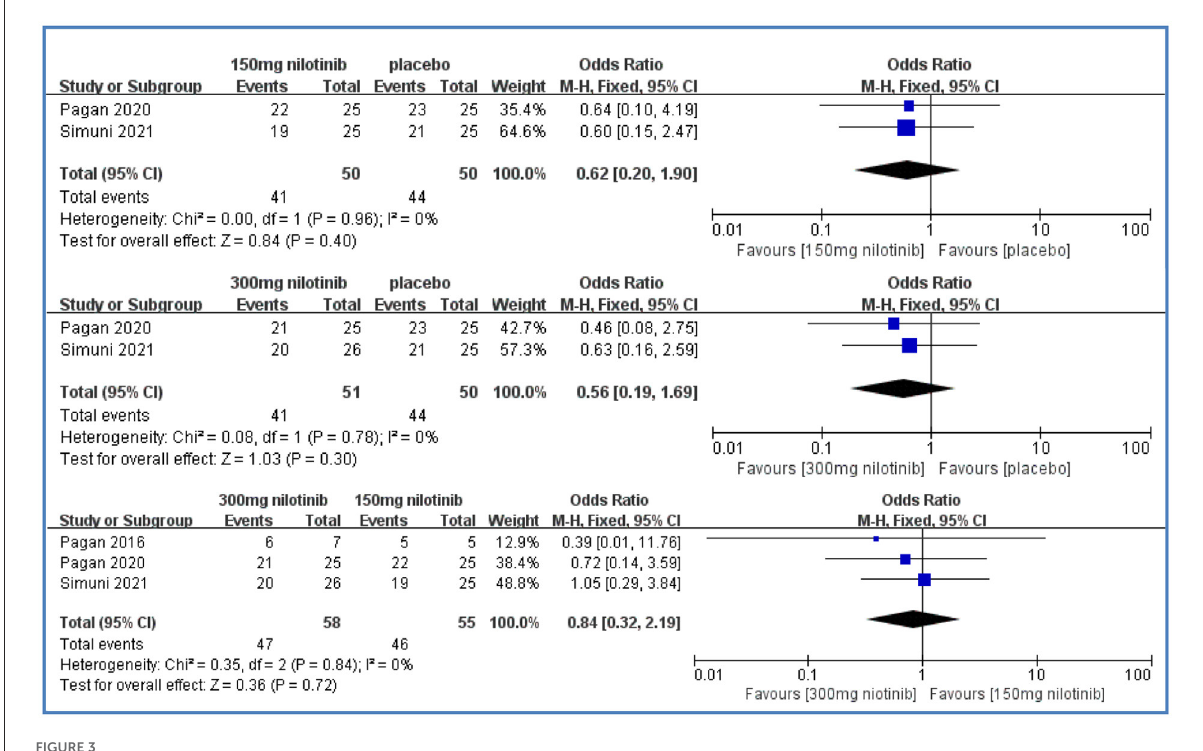
FIGURE3 Forest plot of tolerability.